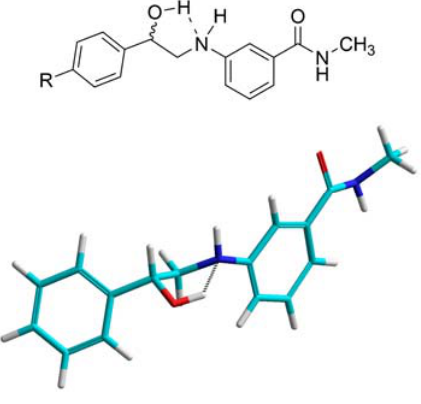
Figure 3. A two-dimensional drawing and a three-dimensional model of a 2-anilinoalcohol showing the suggested intramolecular hydrogen